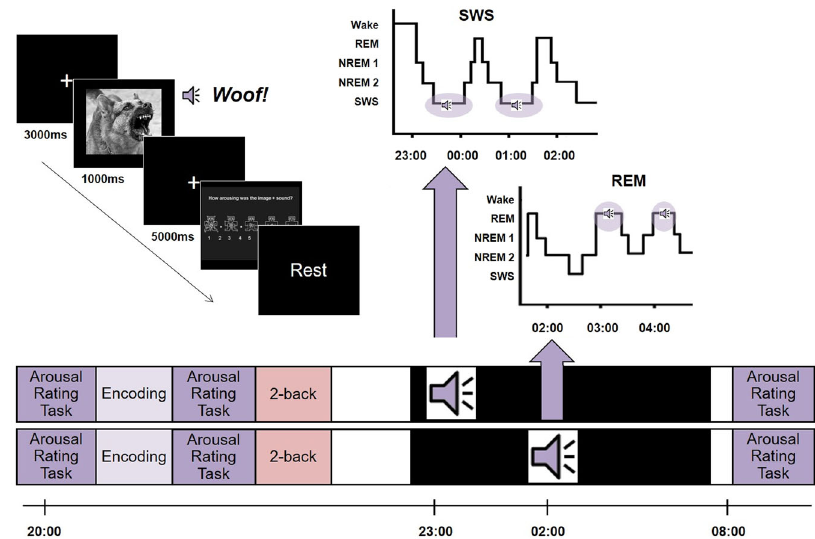
Fig. 1 Experimental design. In the evening session, participants rated each combined picture/sound stimulus for arousal. Next, they completed an encoding task in which they had to indicate which sound was paired with each image. They then completed the arousal rating a second time, as ratings may have changed as a result of the encoding task. Finally, participants performed a visual 2-back task using images that were not seen elsewhere in the experiment to create a buffer between exposure to the highly emotional stimuli and subsequent sleep. They were then fi tted with electrodes for PSG recording and allowed to relax until lights out at approximately midnight. During the night, we performed TMR by exposing participants to the sounds associated with half of the neutral and half the negative learned stimuli in pseudorandom order fi ve times each but avoiding adjacent repetitions. Sound cues were presented during REM in the REM group and during SWS in the SWS group. In the morning, participants were allowed thirty minutes to overcome sleep inertia before performing a fi nal arousal rating task. We examined overnight change in arousal ratings to determine how these had changed across the